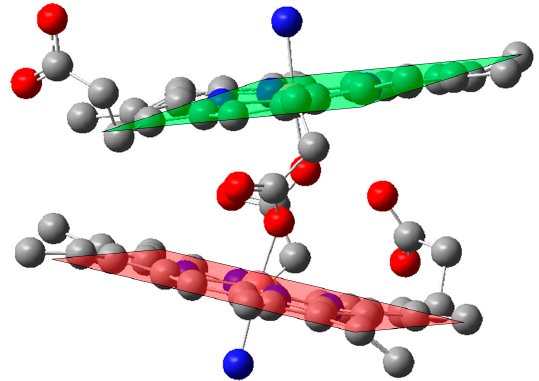
Figure 12. Ball-and-stick representation of the ground state geometry as calculated with DFT at the B3LYP/LANL2DZ level of theory. This DFT-calculated ground state geometry closely resembled the structure obtained later from X-ray analysis [98]. Color coding: grey = carbon, blue = nitrogen, red = oxygen. Reproduced with permission of American Chemical Society [98].